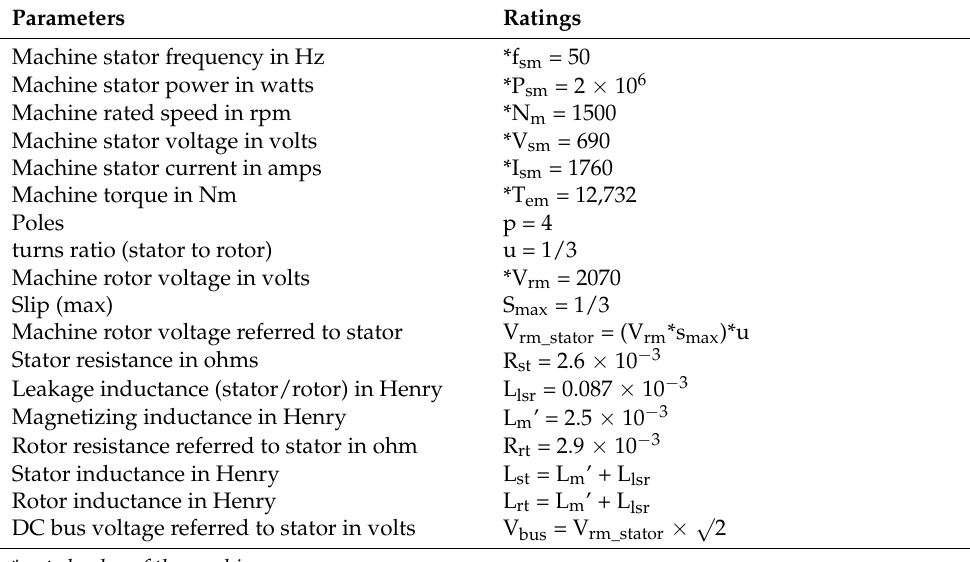
Table A1. Parameters of the proposed